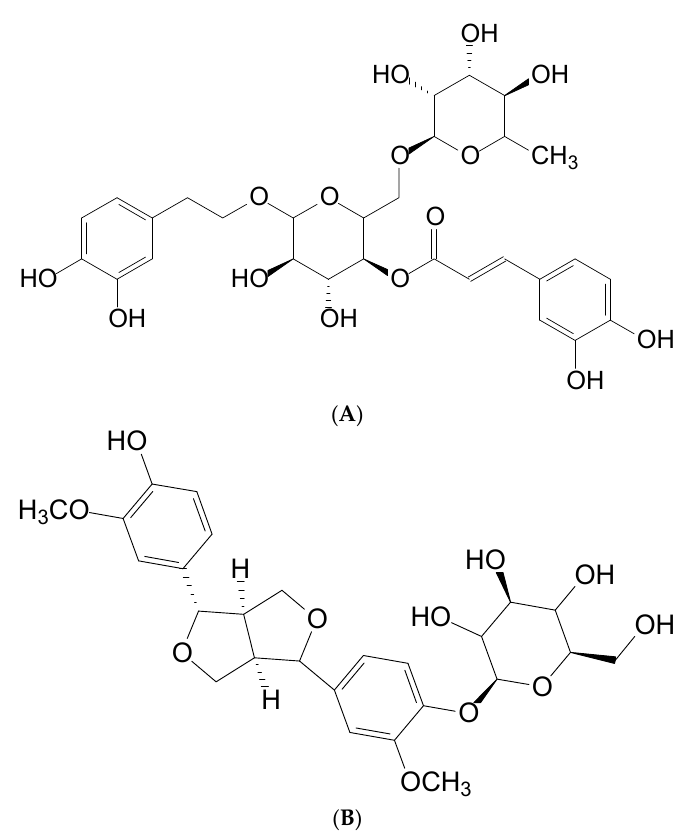
Figure 1. Chemical structure of ( A ) forsythiaside and ( B ) pinoresinol as the internal standard.